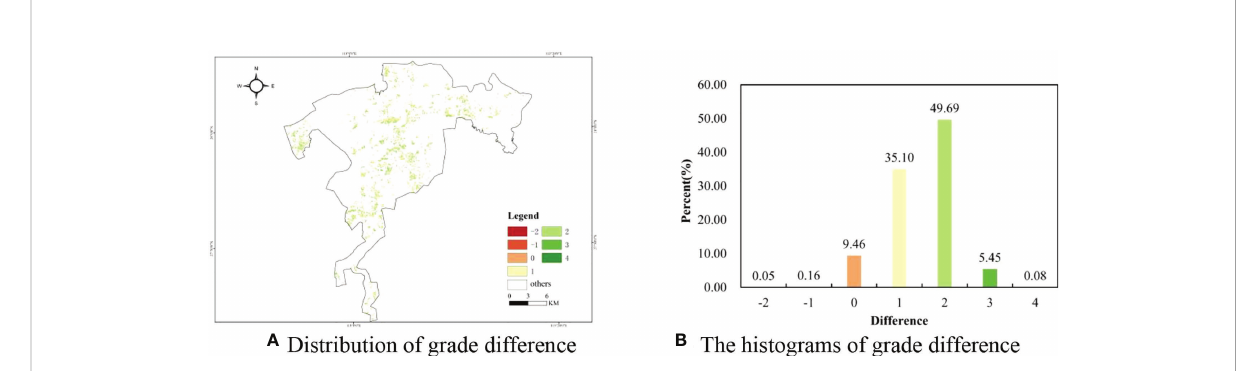
FIGURE 7 The maps and histograms of difference grades between FQ and SQ. (A) Distribution of grade difference (B) The histograms of grade difference.